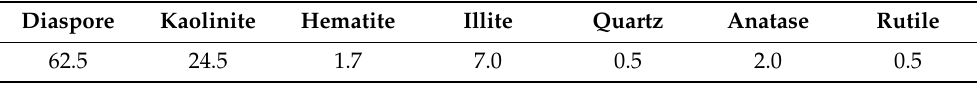
Table 3. Mineral phase composition of lithium-bearing bauxite